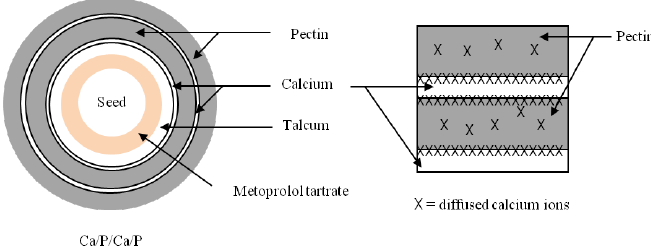
Figure 3. In situ calcium pectinate formation at the interface between the pectin and calcium lay- ers.